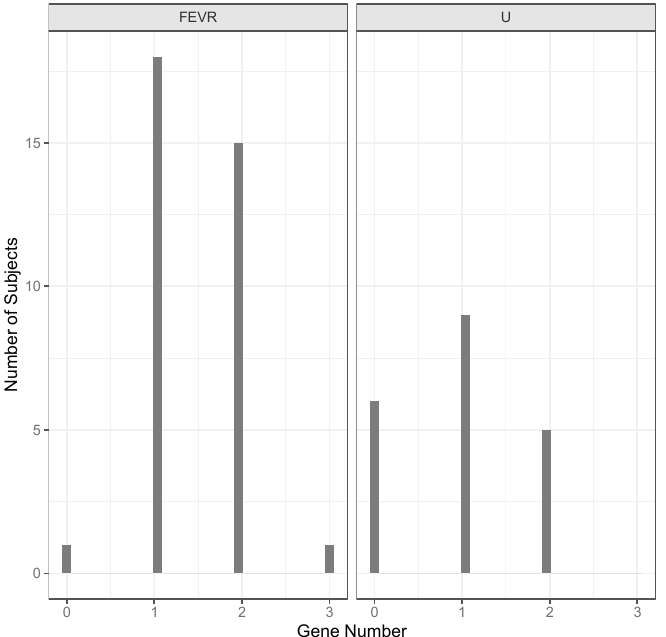
Figure 4. Distribution of the number of affected genes with protein-altering variants in affected and unaffected FEVR subjects. Numbers of genes are shown for 35 FEVR subjects and 20 Unaffected (U) subjects as confirmed by ARC diagnosis.